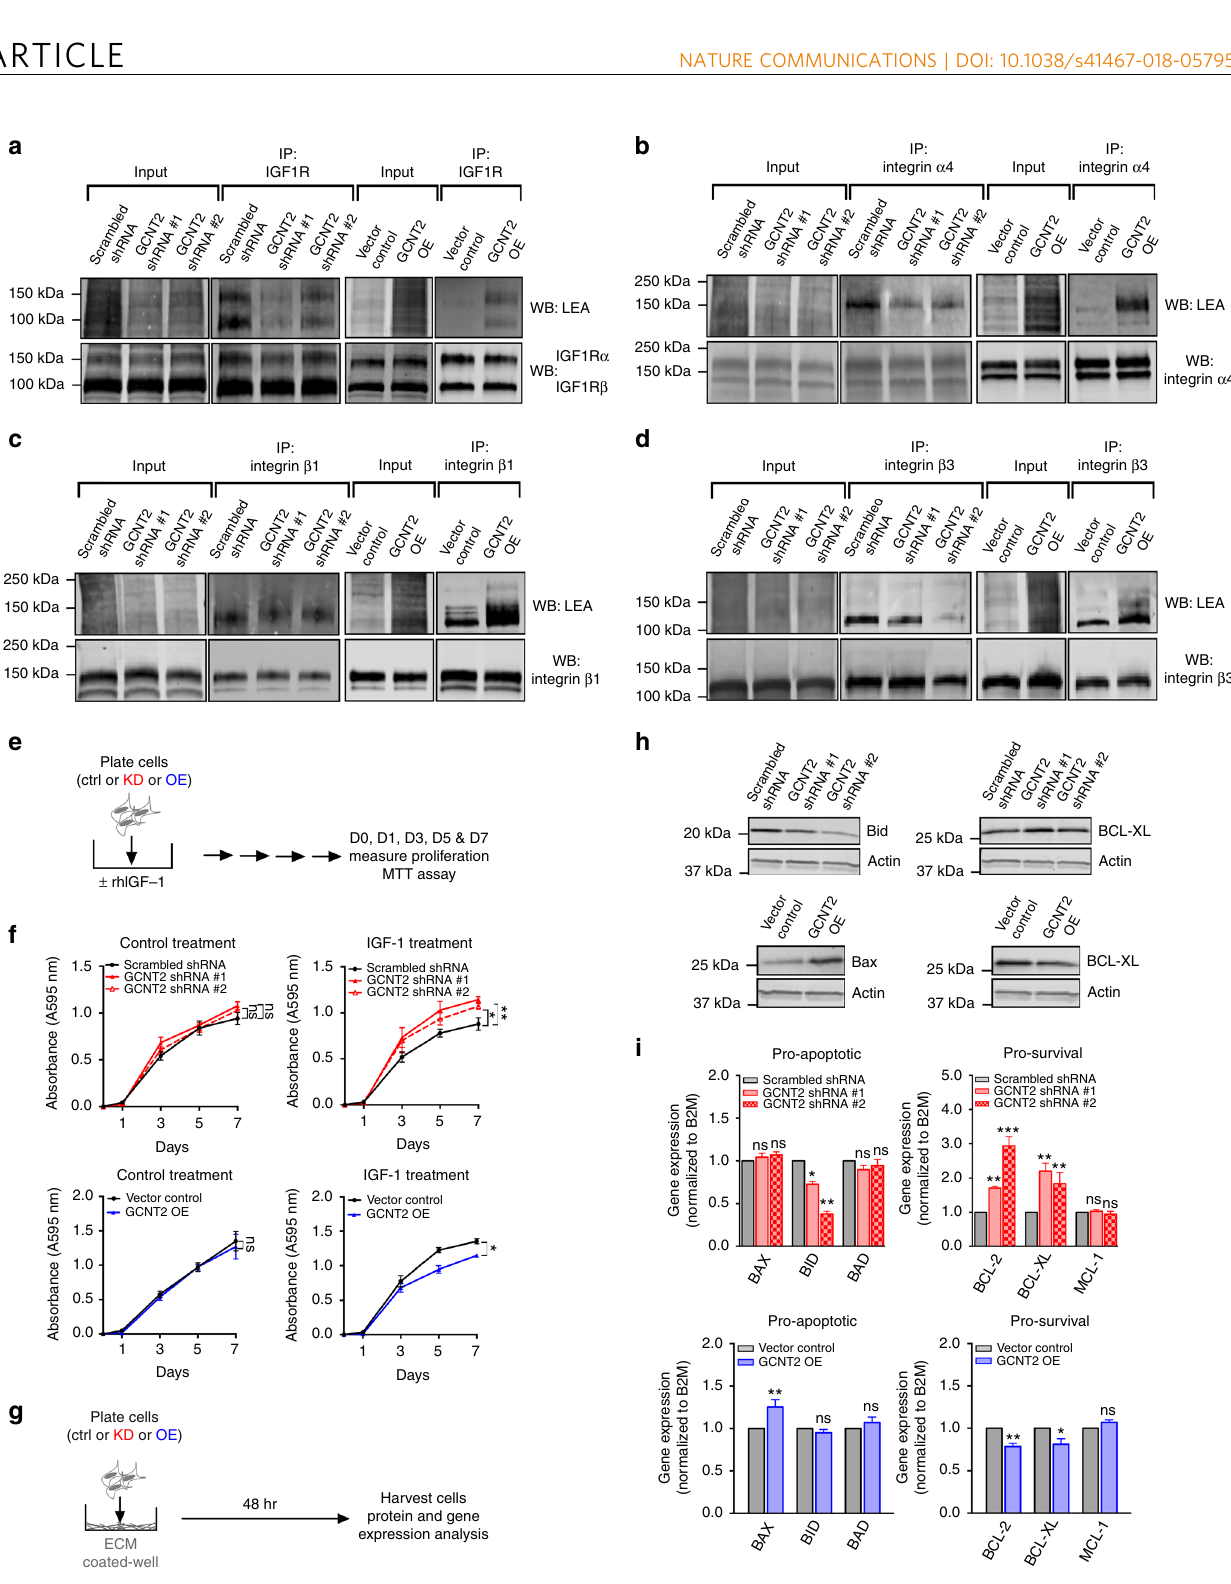
Fig. 5 Growth factor and adhesion-mediated melanoma cell proliferation and survival are increased with loss of GCNT2. a – d Immunoblots of LEA lectin reactivity of IGF1R ( a ), integrin α 4 ( b ), integrin β 1 ( c ), and integrin β 3 ( d ) subunits immunoprecipitated from UACC62 scrambled control and GCNT2 KD and A375 vector control and GCNT2 OE cell variants. e Schematic representation of IGF-1 growth assay. Cells were treated every 3 days with control or with 100 ng/ml recombinant human insulin-like growth factor-1 (rhIGF-1). Cell proliferation was measured using the MTT assay. f Cell proliferation measured by the MTT assay in UACC62 scrambled control and GCNT2 KD (top) cell variants and in A375 vector control and GCNT2 OE (bottom) cell variants. g Schematic representation of ECM-mediated cell survival assay. Cells were plated on an ECM model composed of fi bronectin, laminin, and collagen I for 48 h. Cells were lysed for protein or gene expression analysis by western blot or qRT-PCR. h , i Cell survival family protein ( h ) and gene ( i ) expression measured by western blot and qRT-PCR in UACC62 scrambled control and GCNT2 KD (top) cell variants and in A375 vector control and GCNT2 OE (bottom) cell variants. Statistical analyses were done using two-way ANOVA with Dunnett ’ s or Bonferroni ’ s multiple comparison test or unpaired two-tailed Student ’ s t test. Results are representative of n = 3 experiments (mean ± SEM; ** p < 0.01; *** p < 0.001). See also Supplementary Fig.